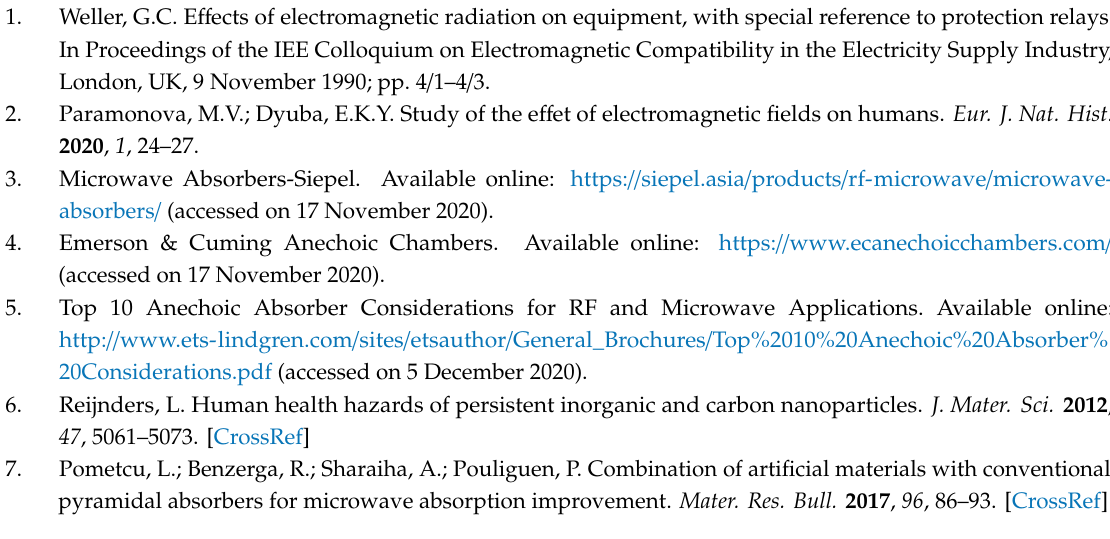
Figure S1: Bundles of carbon fibers: (a) 3 mm, (b) 6 mm and (c) 12 mm supplied by Apply Carbon; Figure S2: Microscopic images of (1) 3 mm-CFs (2) 6 mm-CFs (3) 12 mm-CFs mixed with shear mixing during (a) 0 min (spatula) and (b) 5 min; Figure S3: Epoxy foam loaded with 0.5 wt.% of 3 mm-CFs and 6 mm-CFs prepared with shear mixing for ( a ) 0 min, ( b ) 30 s ( c ) 3 min and ( d ) 5 min; Figure S4: Frequency dependence of the reflection coe ffi cient for epoxy foams loaded with 0.5 wt.% of 12 mm-CFs for three times of shear mixing: 30 s, 3 min and 5 min; Figure S5: Photos of epoxy foams loaded with 0.25 wt.% of carbon fiber with length of (a) 3 mm (b) 6 mm and (c) 12 mm, elaborated using ultrasounds, during 5 min, for CFs dispersion; Figure S6: Microscopic images of (a) 3 mm-CFs, (b) 6 mm-CFs and (c) 12 mm-CFs mixed with ultrasounds during 5 min; Figure S7: Dielectric losses of epoxy foams loaded with 0.25 wt.% of 3, 6 and 12 mm-CFs, presented in X-Band frequency range; Figure S8: Proposed multiple reflections and backscattering in CF agglomerates as a function of the CF length and EM wavelength. Trapped waves (Red arrows); transmitted waves (blue arrows); reflected waves (green arrows); Figure S9: Photo of epoxy foams loaded with 0.25 wt.% of 6 + 12mm-CFs; Figure S10: The frequency dependence of the simulated reflection coe ffi cients for pyramidal epoxy foams loaded with 0.25 wt.% of 3, 6, 12 and 6 + 12 mm-CFs compared to the measurement and the simulation of a prototype loaded with 0.5 wt.% of 3